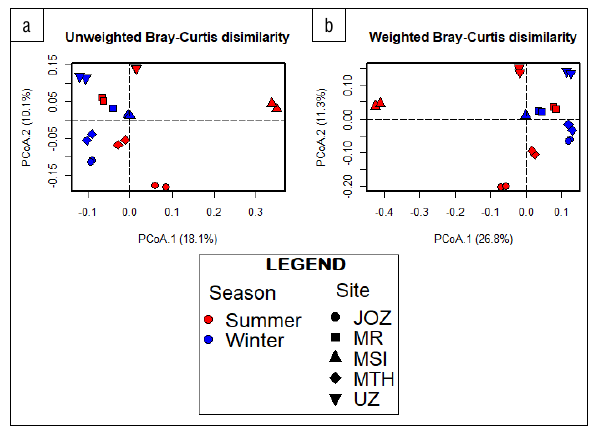
Figure 3: Principal coordinate analyses (PCoA) of Bray–Curtis distance matrix showing differences between summer and winter faecal bacterial communities of Zulu sheep: (a) unweighted and (b) weighted. Effects of interaction between season and site are significant (PERMANOVA p <0.001).